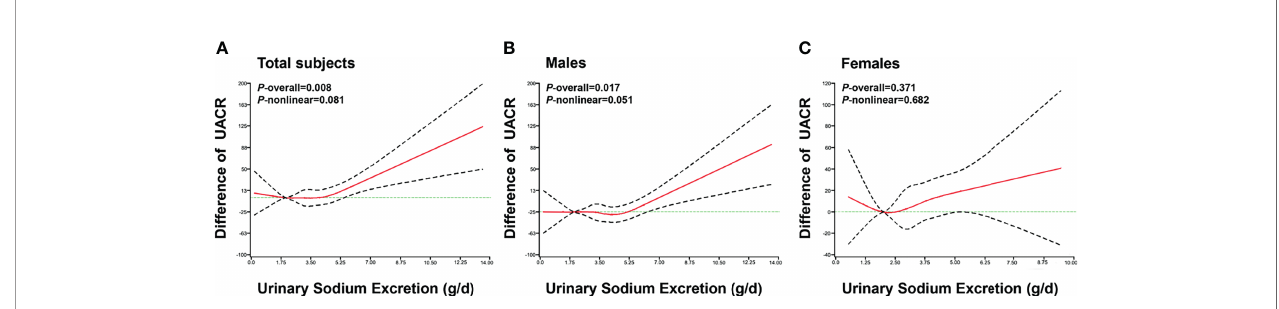
FIGURE 1 | The association of urinary sodium excretion with UACR level. The restricted cubic spline (RCS) regression was used to analyze the relationships of urinary sodium excretion (g/d) with urinary albumin to creatinine ratio (UACR) after adjusting for age, gender, BMI, smoking, alcohol consumption, DBP, RAS blocking agents, diuretics, hyperlipidemia, statin, HbA1c and antidiabetic drugs in total subjects (A) , males (B) , females (C) . Urinary sodium excretion was coded using an RCS function with fi ve knots located at the 5th, 25th, 50th, 75th, 95th percentiles of the distribution of urinary sodium excretion. Y-axis represents the difference in UACR between individuals with any value of urinary sodium excretion with individuals with 2g/d of urinary sodium excretion. X-axis represents the continuous change of urinary sodium excretion. Black dashed lines are 95 percent con fi